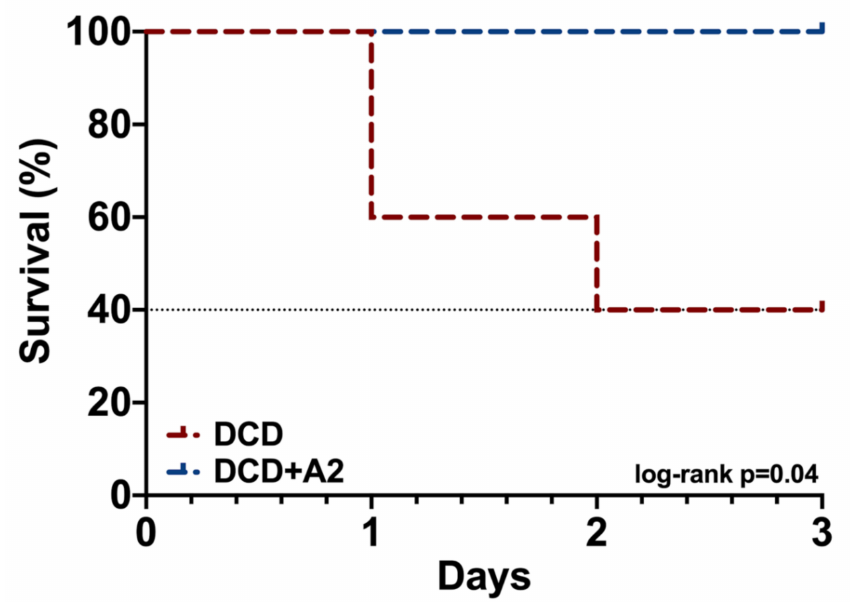
Figure 5. Animal survival. Kaplan–Meier analysis and log-rank test for 3-day animal survival ( p = 0.04 log-rank test, n = 5 /